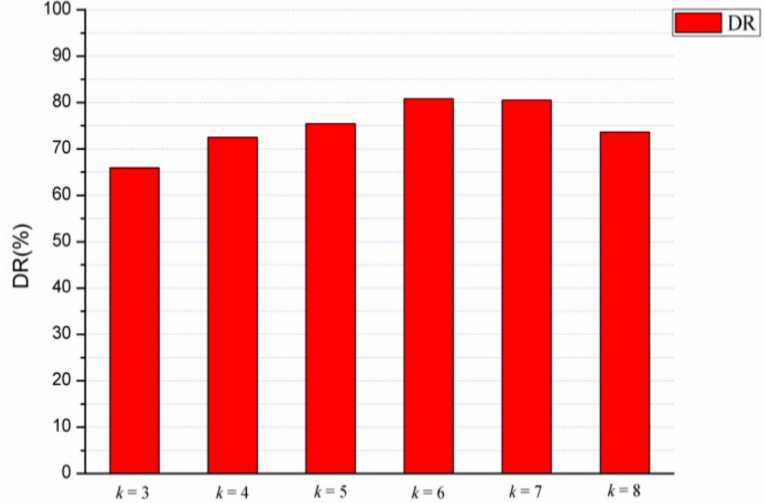
Figure 10. The comprehensive detection rate of di ff erent k on UNM_sendmail